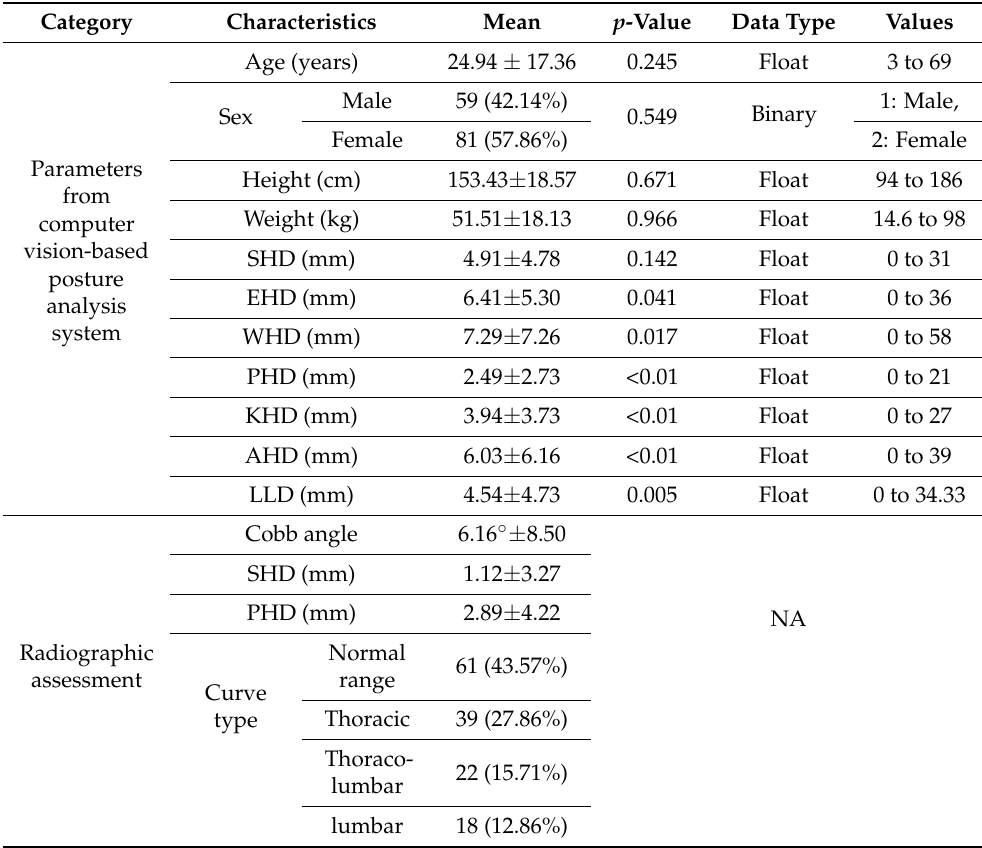
Table 2. Participant characteristics and parameters using a computer vision-based posture analysis system for predictive modeling analysis. Category